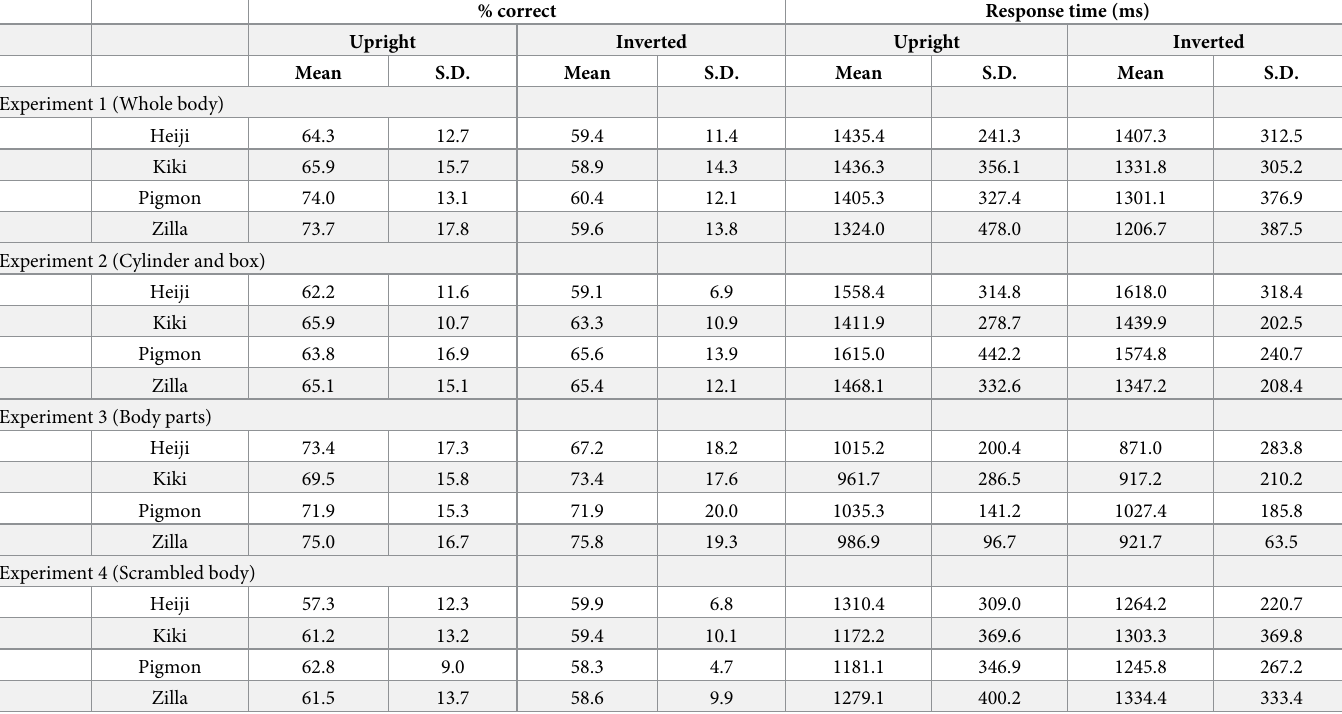
Table 2. Mean percentages of correct responses and mean response time in eight test sessions for each stimulus orientation condition and each individual in Experi- ments 1 to